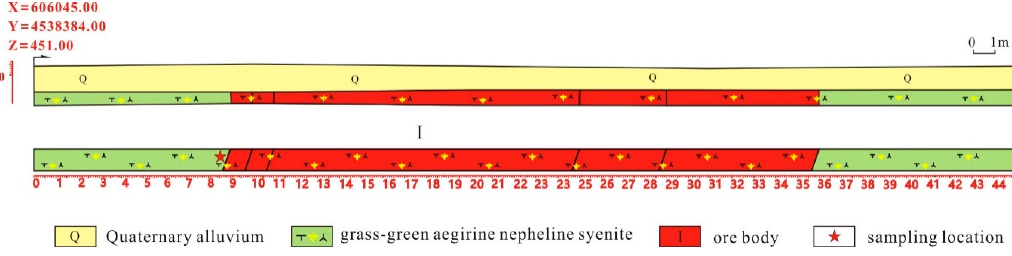
Figure 2. TCG10-3 trench exploration map of the Saima deposit in Fengcheng, Liaoning Province.